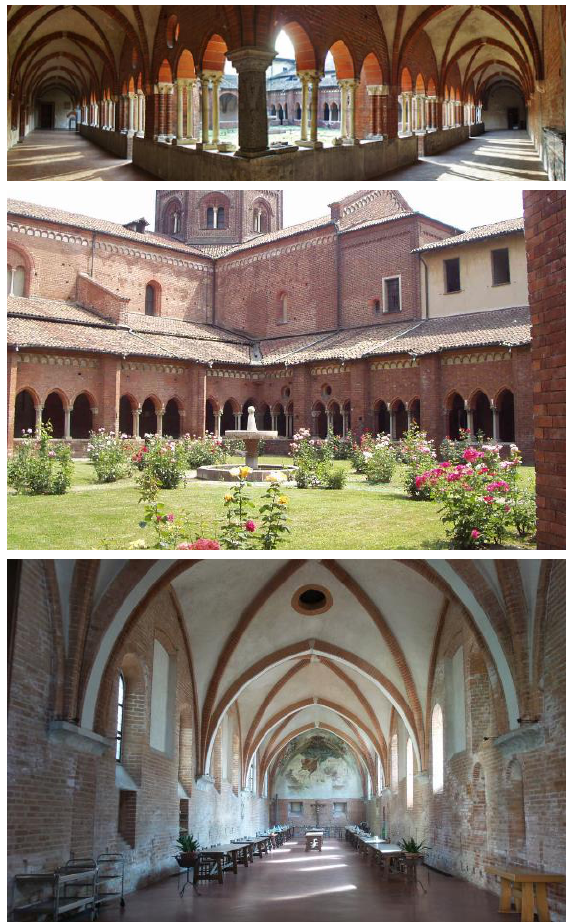
Figure 2. Some images of the cloister and refectory of the Chiaravalle Abbey (Milan, Italy).